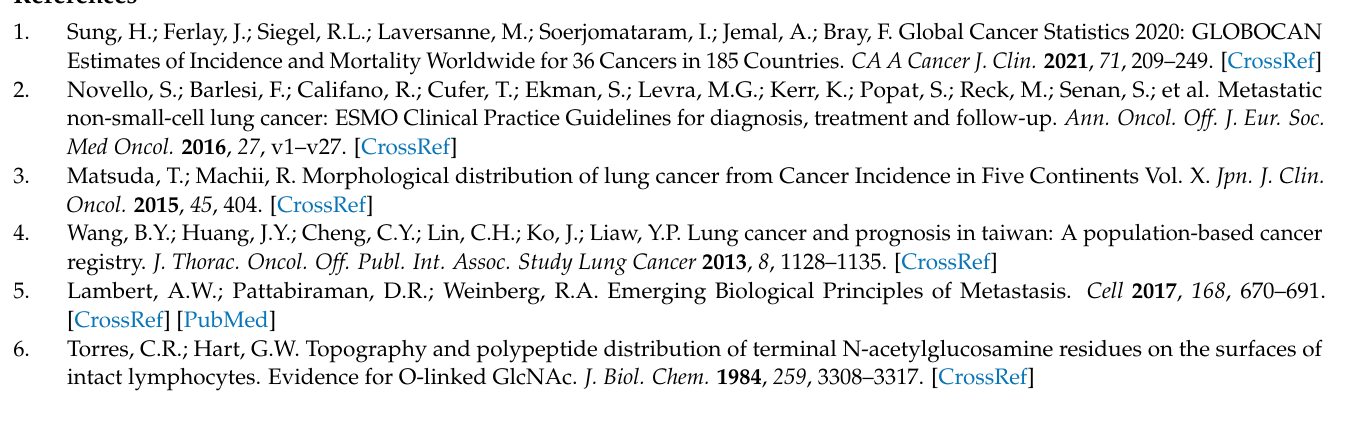
teins, Figure S2: Gene ontology analysis, Figure S3: The actin cytoskeleton signaling pathway, Figure S4: Identification of O -GlcNAcylation sites by MS/MS analysis, Figure S5: Comparison of O -GlcNAcylation levels of wild-type and mutant SAM68, Figure S6: Kaplan-Meier analysis of the overall survival of patients with lung adenocarcinoma, Figure S7: Full Western blot for Figure 1B, Figure S8: Full Western blot for Figure 2C,D, Figure S9: Full Western blot for Figure 3A–C, Figure S10: Full Western blot for Figure 4B, Figure S11: Full Western blot for Figure 4C, Figure S12: Full Western blot for Figure 4D, Figure S13: Full Western blot for Figure 5A and 5D, Figure S14: Full Western blot for Figure S1, Figure S15: Full Western blot for Figure S5, Table S1: Differential nuclear WGA-bound proteins, Table S2: Differential cytosolic WGA-bound proteins, Table S3: Significant network func- tions, Table S4: Significant canonical pathways, Table S5: Significant molecular and cellular functions, Table S6: Association of SAM68 expression with lung adenocarcinoma